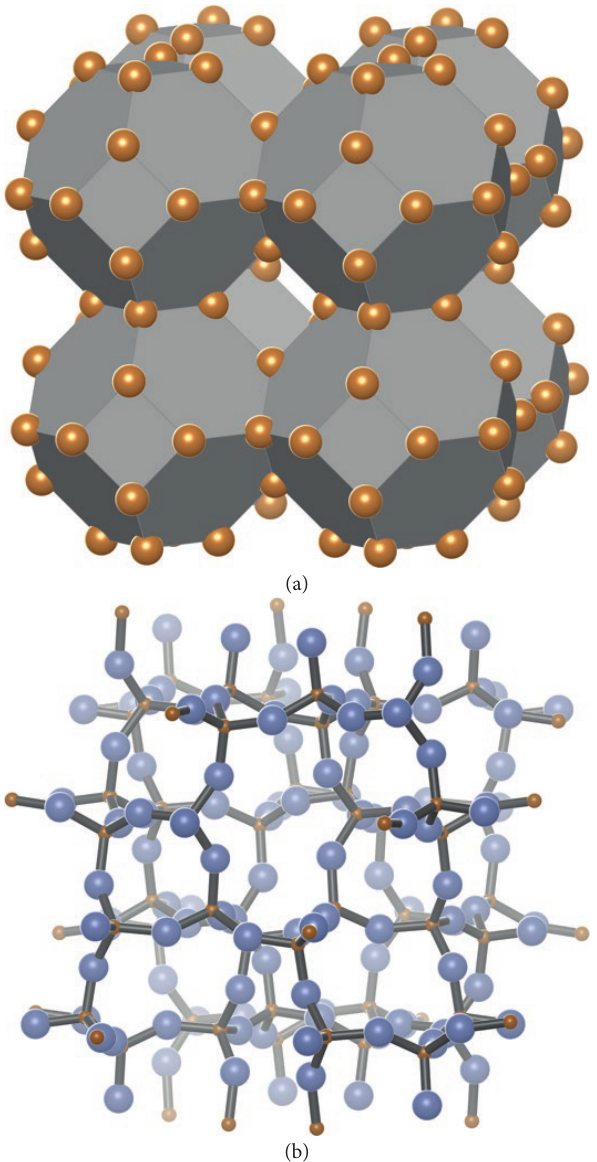
Figure 2. Pictures of zeolites: (a) Ball and stick model of the anal- cime framework. Links represent Si-O-Si bonds in the idealised sili- cate, balls the Si positions. (b) Polyhedral model of the structure of sodalite (face-sharing truncated octahedra), with Si at the vertices.